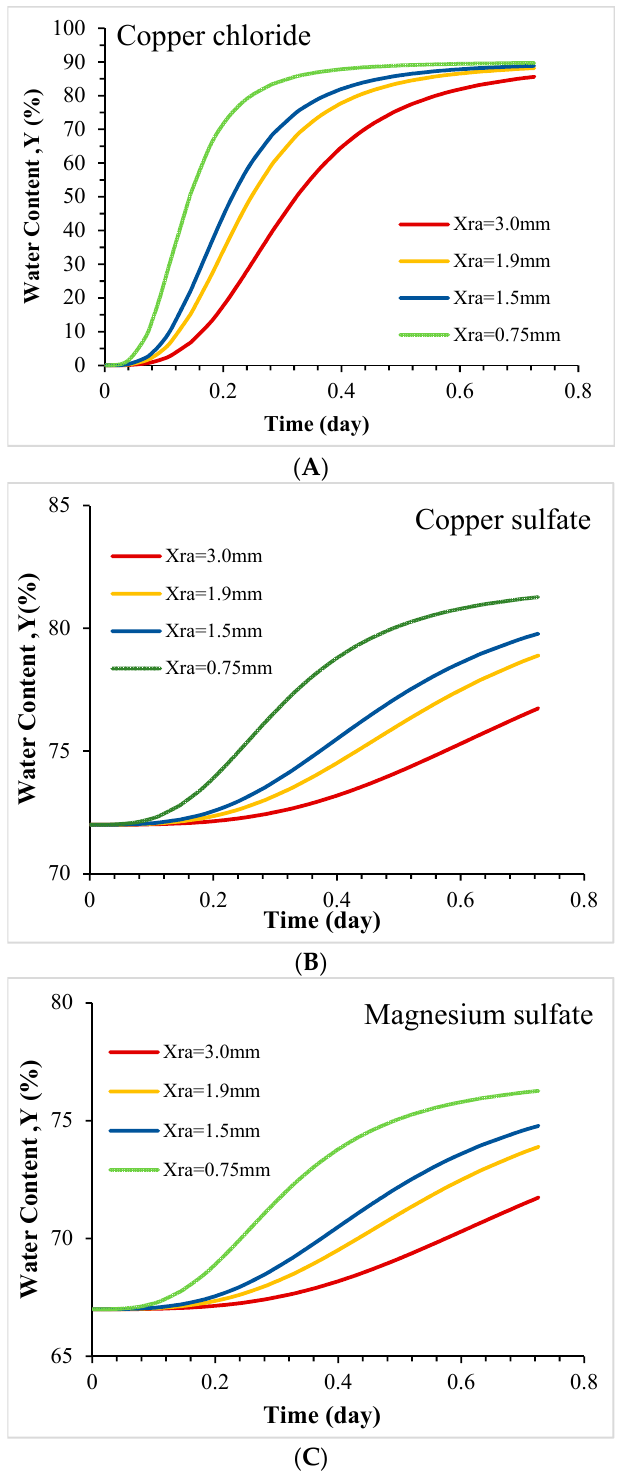
Figure 6. Water vapor absorption curves of the three salts: ( A ) copper chloride, ( B ) copper sulfate, and ( C ) magnesium sulfate under different thicknesses.